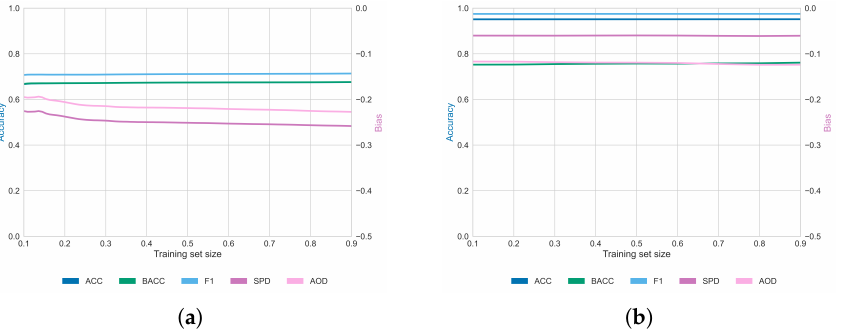
Figure 6. Performance results for LRC on differently sized training sets. Model performance was evaluated using the average of ten stratified train–test splits. For SPD and AOD, values closer to zero indicate more fairness. ( a ) COMPAS; ( b ) LAW.